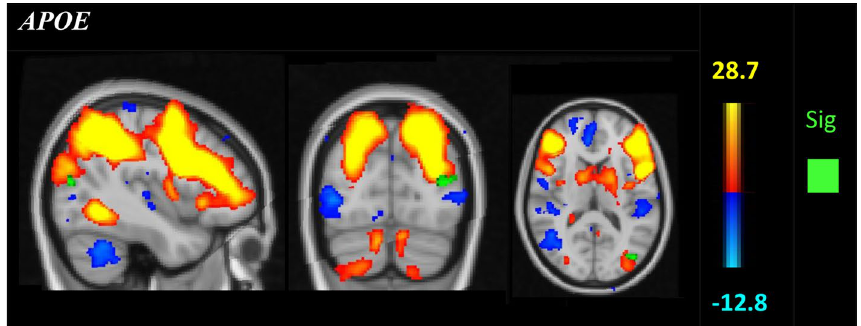
Figure 1. Red-yellow represent the dorsal attention network (DAN) after performing a group-ICA. Green voxels show increased functional connectivity in ε3 homozygotes compared to ε4 carriers in the occipital cortex ( p < 0.05 family-wise error [FWE]-corrected). Montreal Neurological Institute (MNI) coordinates x = − 42, y = − 80, z = 16. Results were controlled for age, cognitive reserve, and GM maps and the significance was still there. Data was analysed with FMRIB Software Library 31 and displayed in FSLeyes (https:// git. fmrib. ox. ac. uk/ fsl/ fsley es/ fsley es/).